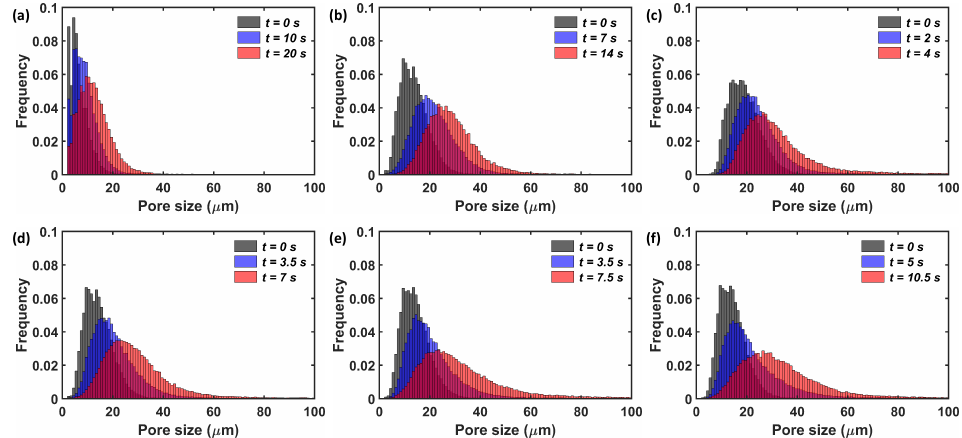
Figure 8. Pore size distribution at different time points during swelling of the tablet. ( a ) PH101, (cid:101) 0 = 10%. ( b ) PH101, (cid:101) 0 = 15%. ( c ) PH101, (cid:101) 0 = 22%. ( d ) PH101/CCS, c CCS = 2%. ( e ) PH101/CCS, c CCS = 5%. ( f ) PH101/CCS, c CCS = 8%. The time points analysed: starting point (0 s), halfway point of reaching maximum swelling capacity and at the time point of maximum swelling